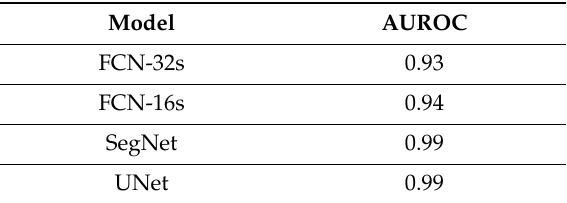
Table 5. AUROC values per model.